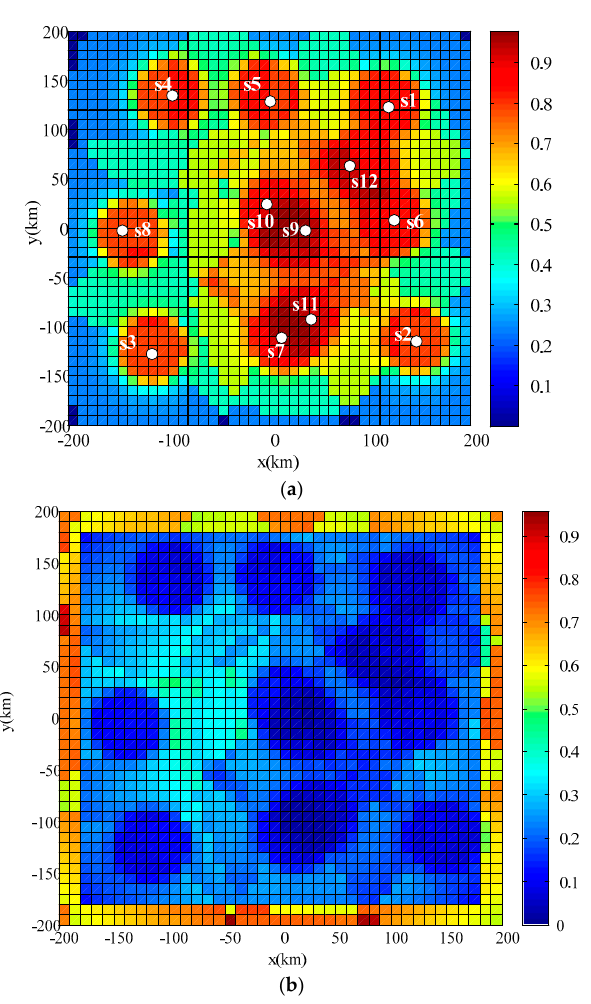
Figure 7. Sensor deployment after optimization. ( a ) Target detecting probability distribution; ( b ) target detecting risk distribution.